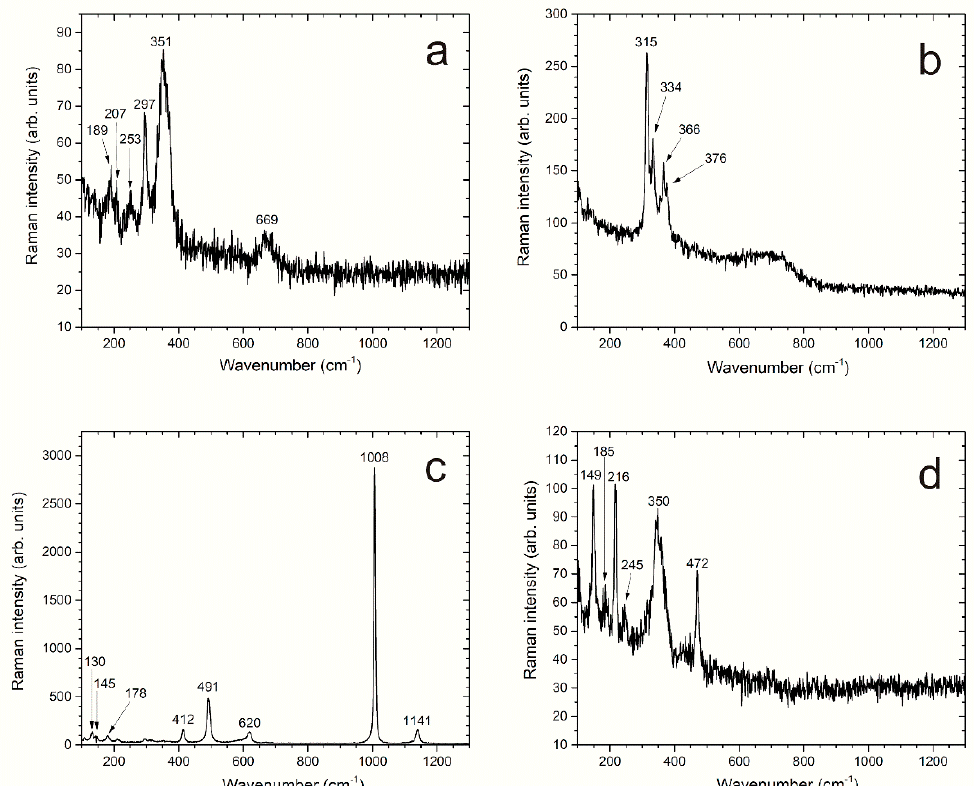
Figure 3. Typical Raman spectra obtained during the analysis of carbon steel samples after the experiment. ( a ) Greigite/mackinawite/magnetite mixture; ( b ) unknown compound; ( c ) gypsum; ( d ) greigite/elemental sulfur.